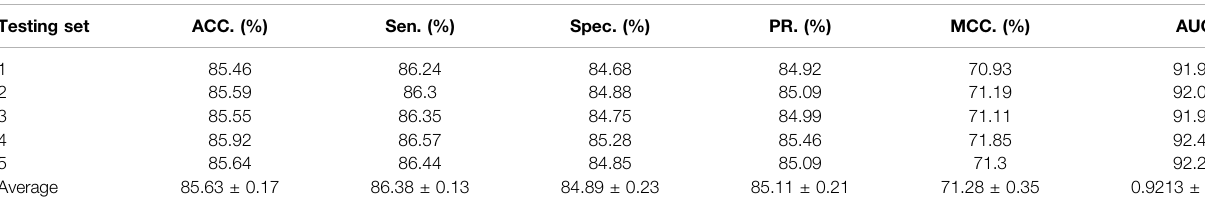
TABLE 3 | Prediction performance on the Oryza sativa dataset with the multiple feature. Testing set